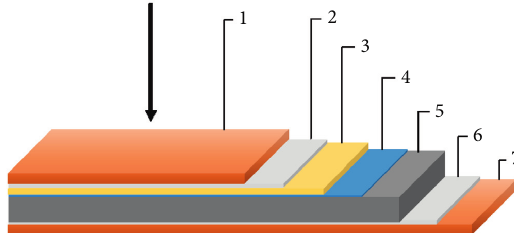
Figure 4: The structure of 2G HTS tapes. 1, Cu (20 µ m); 2, Ag (2 µ m); 3, YBa 2 Cu 3 O 7 (1 µ m); 4, buffer layers from metal oxides (70 nm); 5, substrate Hastelloy C276 (Ni-Cr-Mo-Fe) (50 µ m); 6, Ag (2 µ m); 7, Cu (20 µ